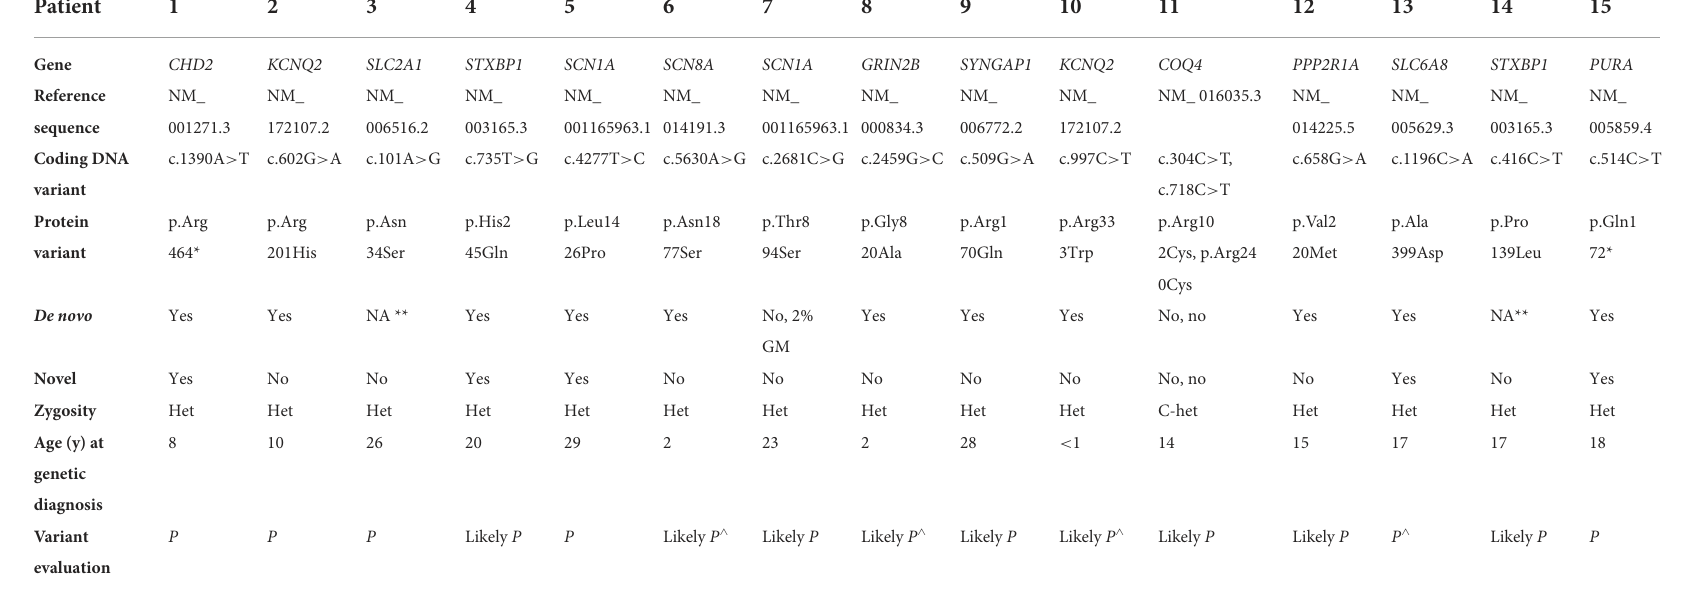
TABLE 2 Genetic